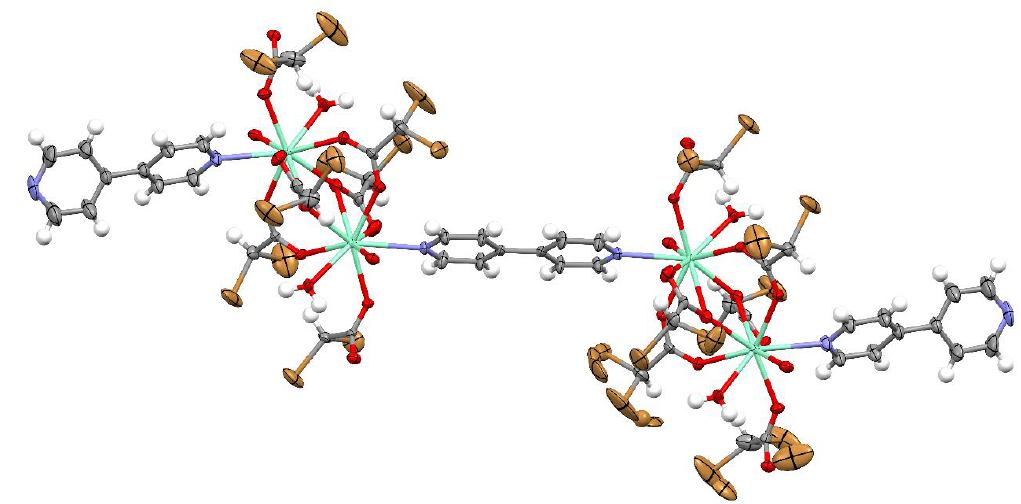
Figure 4. The molecular structure of the complex with Sm(III) (compound 2), the displacement ellipsoids are drawn at the 50% probability level except H atoms.